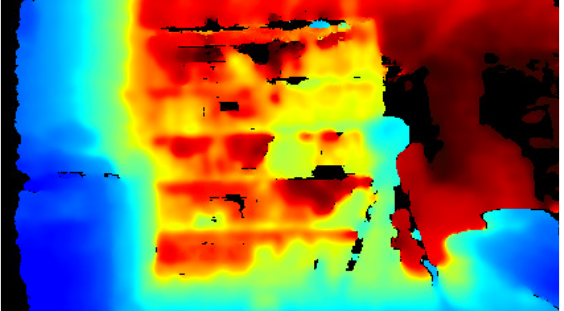
Figure 15. Scene in jet color scale, from blue to red representing distances closest to the camera in blue and furthest from the camera in